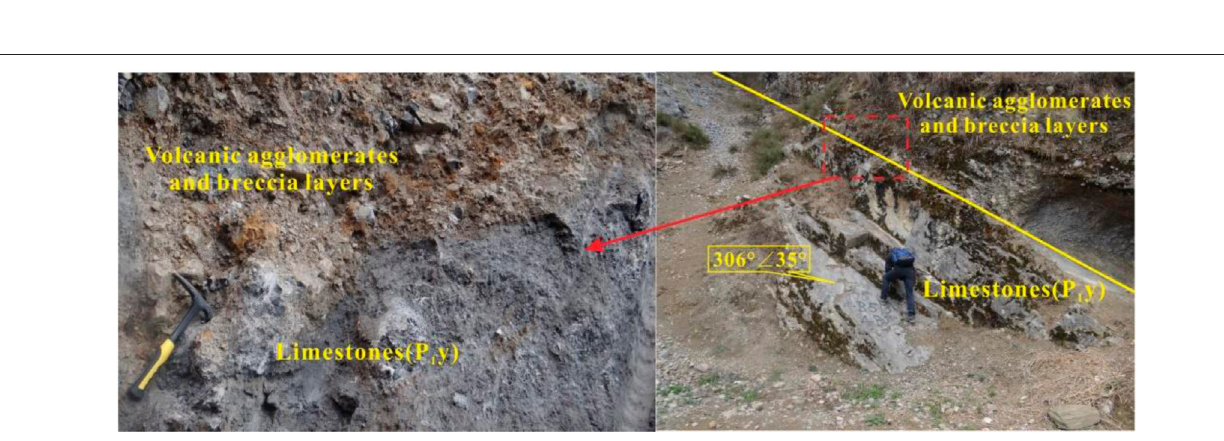
Frontiers in Earth Science |